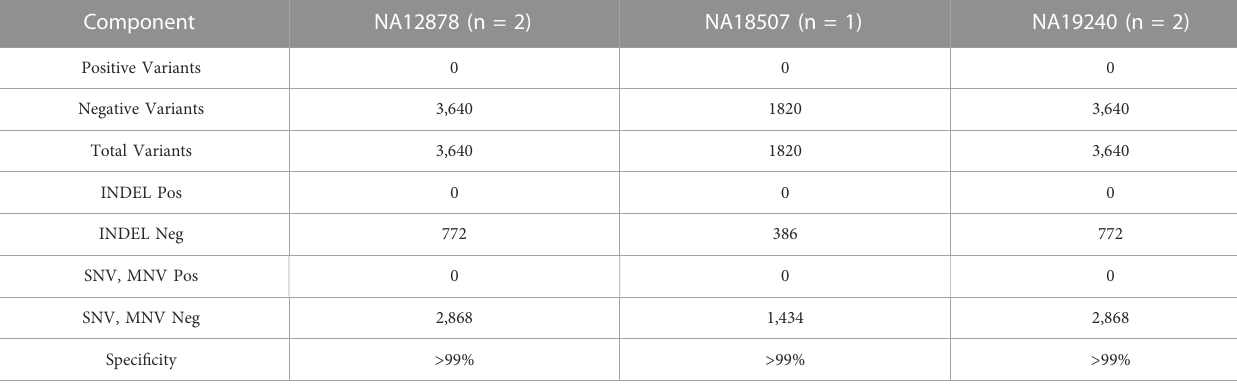
TABLE 12 Speci fi city. Analytical speci fi city of DNA samples.